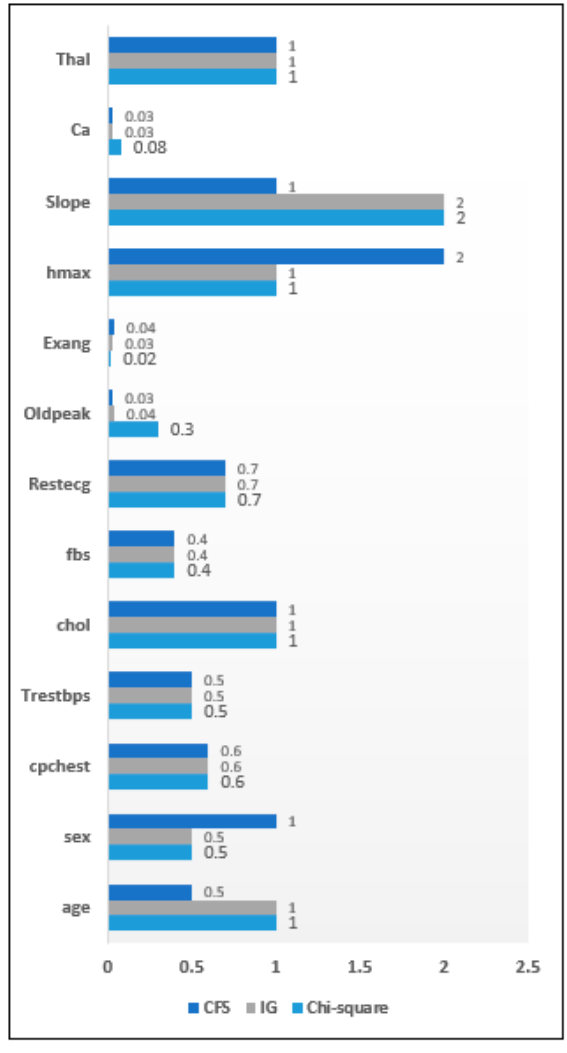
Figure 6. Attribute Significance Graph for the Heart disease dataset with Filters.